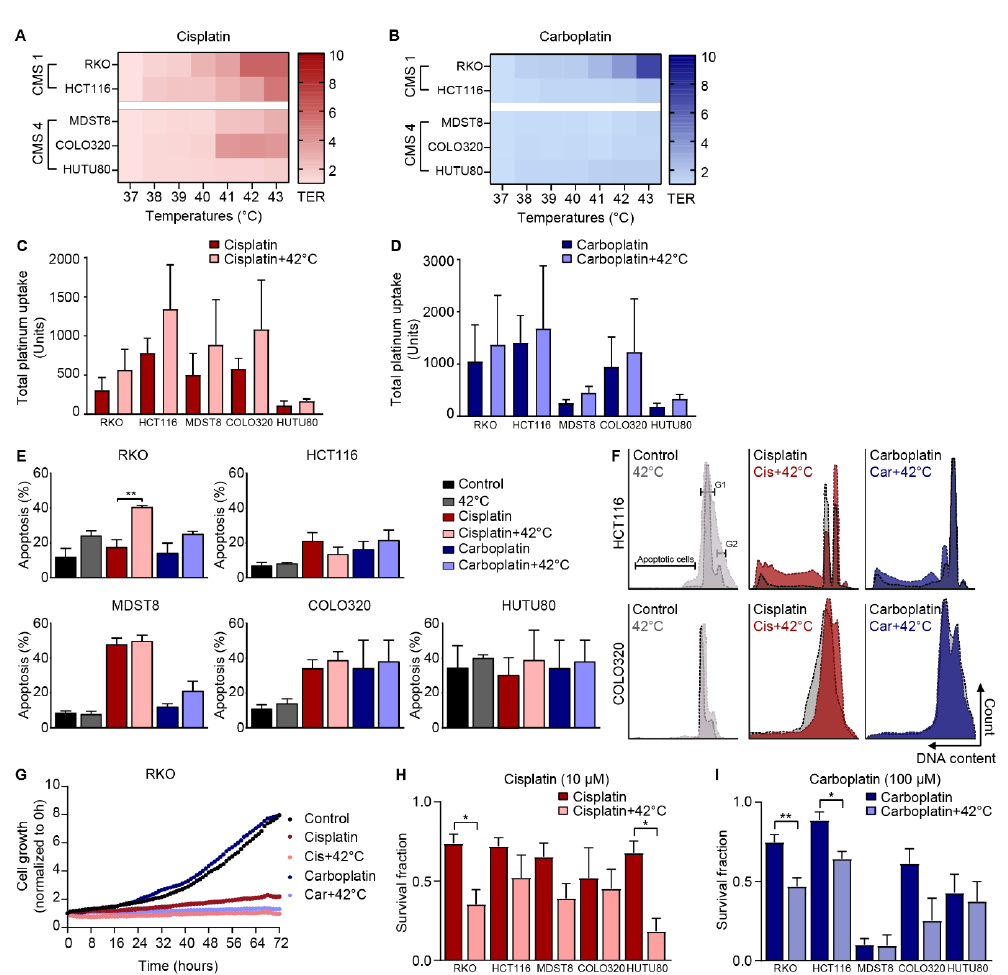
Figure 3. The e ff ect of cisplatin and carboplatin is also temperature-dependent in colorectal cancer cells. To study the temperature-dependent e ff ect of other platinum-based drugs, RKO, HCT116, MDST8, COLO320, and HUTU80 cells were exposed to cisplatin or carboplatin, under hyperthermic condition for 60 min. Cell viability assays were performed 48 h after treatment with cisplatin ( A ) or carboplatin ( B ). Thermal Enhancement Ratio (TER) values are demonstrated by a color gradient: a darker color indicates higher TER values. Data represent the mean of 3 independent experiments. The cellular uptake of cisplatin ( C ) and carboplatin ( D ) was assessed by measuring platinum uptake in cells using the CyTOF at 1 h after treatment. Means ± standard error of the mean of 3 independent experiments are presented. Apoptosis levels ( E ) and cell cycle distribution ( F ) was studied using the Nicoletti assay, which was performed 48 h after treatment. Representative flow charts of HCT116 and COLO320 cells are presented. ( G ) Live cell imaging was used to study the growth of RKO cells after treatment. Clonogenic survival assays were performed to assess long-term cell survival at 10 days after cisplatin ( H ) or carboplatin ( I ) treatment. Means ± standard error of the mean of 4 independent experiments are presented. * p < 0.05, ** p < 0.01.